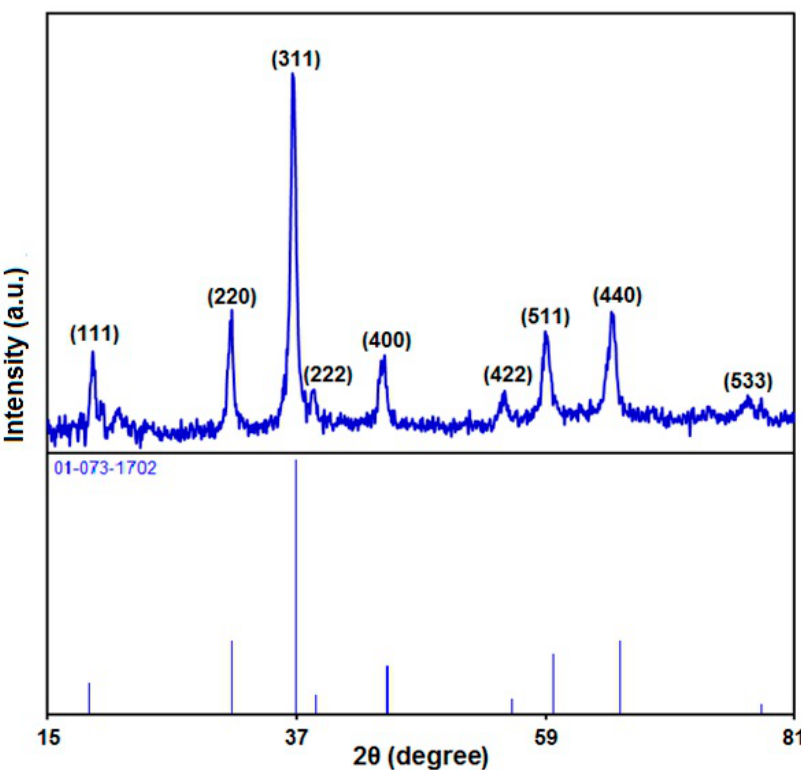
Figure 3. XRD pattern of hierarchical flower-like NiCo 2 O 4 nanoplates.